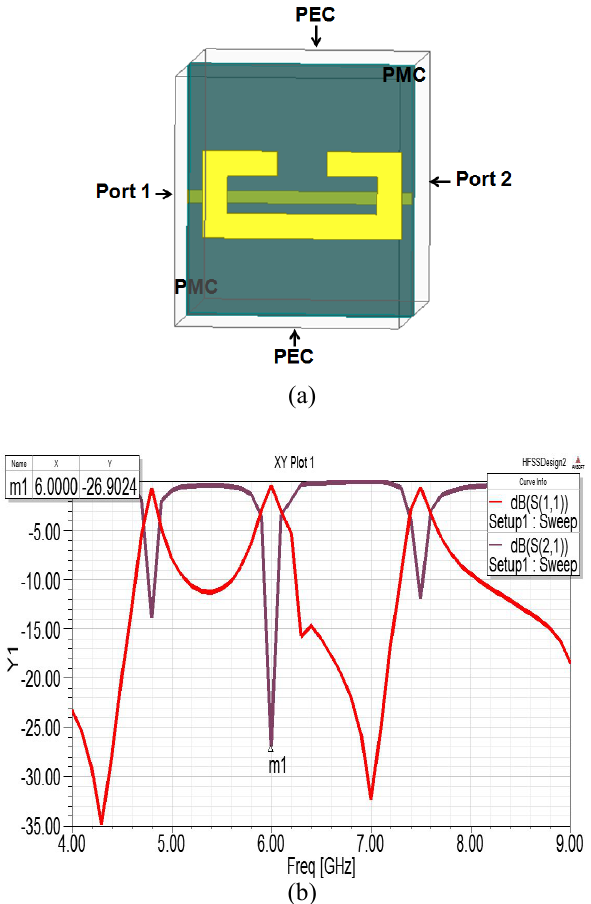
Figure 4. (a). Wave guide setup to retrieve S – parameters (b)retrieved S – parameters